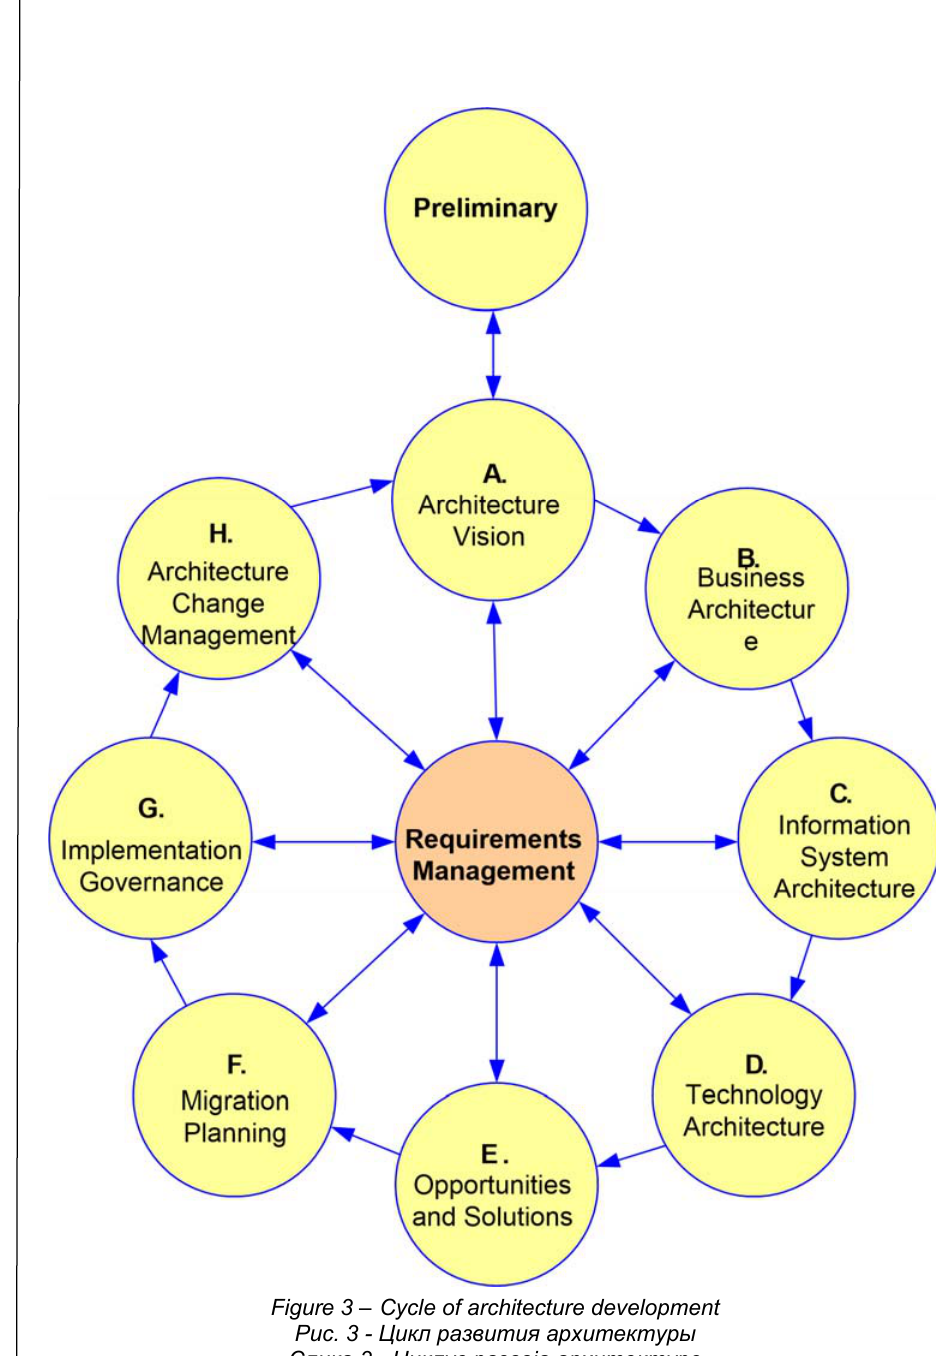
Figure 3 – Cycle of architecture development Puc. 3 - Цикл развития архитектуры Слика 3 - Циклус развоја